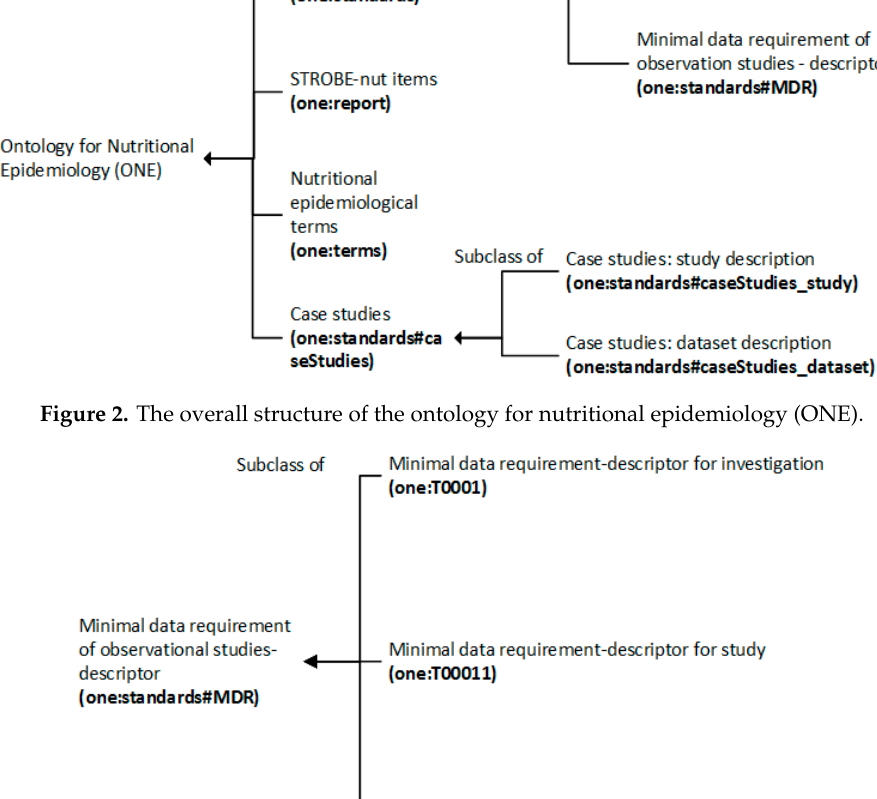
Figure 2. The overall structure of the ontology for nutritional epidemiology (ONE).